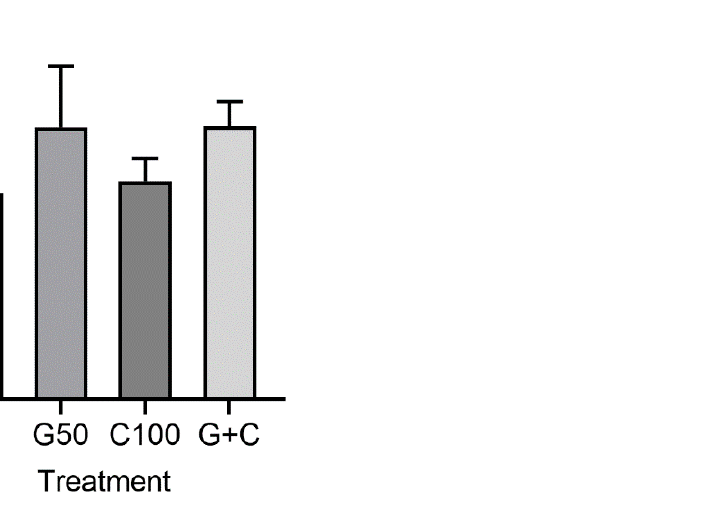
Figure 4. MTT assay of the 3D GTEs generated from the TIGKs and the hGFBs-populated collagen gels with/without genipin or/and cytochalasin D crosslinking in 2-week air–liquid interface culture. Abbreviations: hGFBs: hTERT-immortalized gingival fibroblasts; TIGKs: hTERT-immortalized gingival keratinocytes, GTE: gingival tissue equivalent; Ctrl: control; G50: 50 µM genipin; C100: 100 nM cytochalasin D; G + C: G50 + C100.